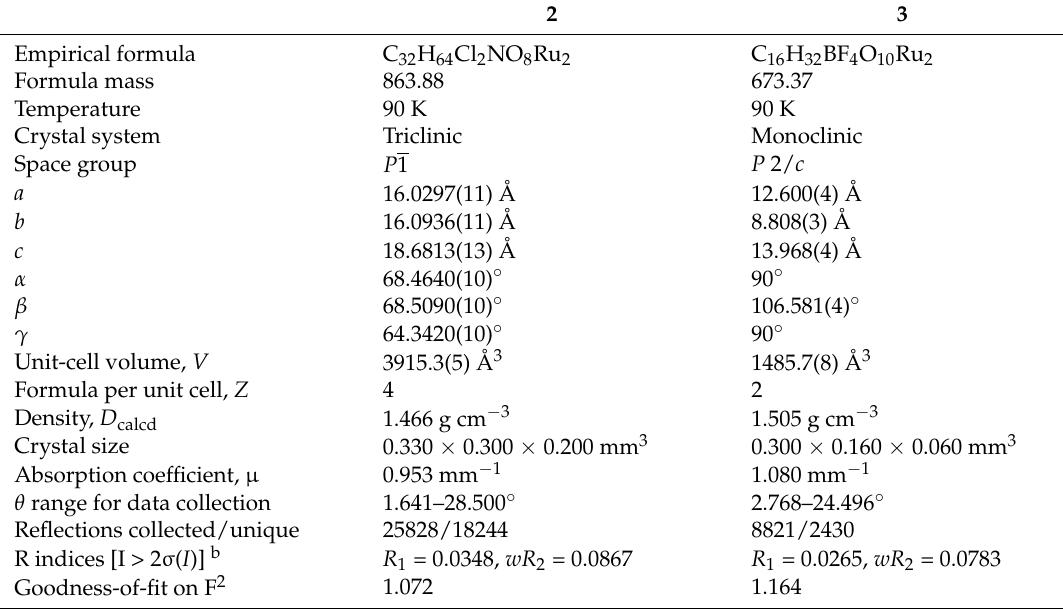
Table 1. Crystallographic data of n Bu 4 N[Ru 2 (O 2 CC 3 H 7 ) 4 Cl 2 ] ( 2 ) and [Ru 2 (O 2 CC 3 H 7 ) 4 (H 2 O) 2 ]BF 4 ( 3 ) a